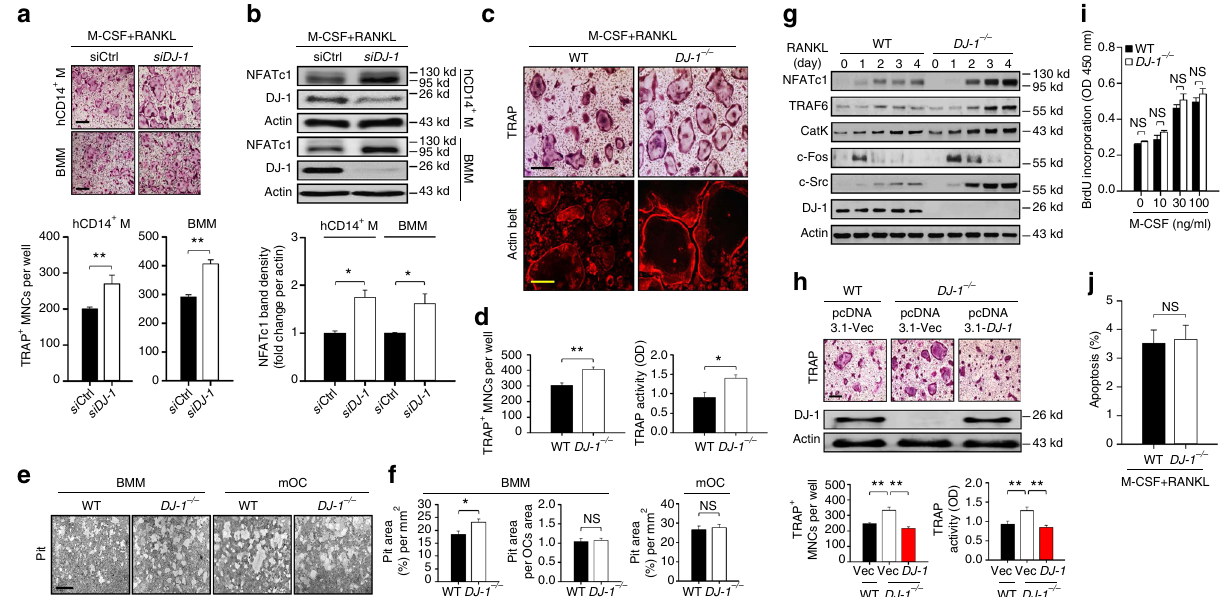
Fig. 2 De fi ciency of DJ-1 increases OC differentiation. a Representative images (upper panel) of TRAP + multinucleated osteoclasts (OCs) in DJ-1 siRNA transfected human CD14 + monocytes (hCD14 + M) or mouse BMMs. Magni fi cation, ×100 and scale bar, 200 μ m. The number of TRAP + OCs (lower panel). b Representative immunoblot images (upper panel) for NFATc1 in human CD14 + monocytes or mouse BMMs stimulated by RANKL for 48 h. Band density of NFATc1 (lower panel). c Representative images for TRAP + OCs (Magni fi cation, ×100 and scale bar, 200 μ m) and actin belt formation (rhodamine- phalloidin; Magni fi cation, ×200 and scale bar, 100 μ m) in WT or DJ-1 − / − BMMs by RANKL. d The number of TRAP + OCs and TRAP activity in WT or DJ-1 − / − BMMs for the upper panel of c . e Representative images for bone resorption by OCs. Magni fi cation, ×200 and scale bar, 100 μ m. f Pit area (left), pit area per OCs area (middle) by BMMs and pit area by mOCs (right). g Representative immunoblot images for OC marker proteins in WT or DJ-1 − / − BMMs. h Representative image for TRAP + OCs (upper panel, Magni fi cation, ×100 and scale bar, 200 μ m). The number of TRAP + OCs and TRAP activities were measured in WT or DJ-1 − / − BMMs overexpressed with DJ-1 plasmid or empty vector (lower panel). Representative images and data shown as the mean ± s.e.m. from three independent experiments in triplicate. ** p < 0.01 by one-way ANOVA with post hoc Tukey ’ s test. i Measurement of proliferation by BrdU incorporation in WT or DJ-1 − / − BMMs for 3 days; n = 5. j Frequency of apoptotic cells in BMMs for 2 days. a , b , d , f , i , j The data shown as the mean ± s.e.m. from three independent experiments in triplicate. ** p < 0.01, * p < 0.05, NS, not signi fi cant vs. WT by Student ’ s t